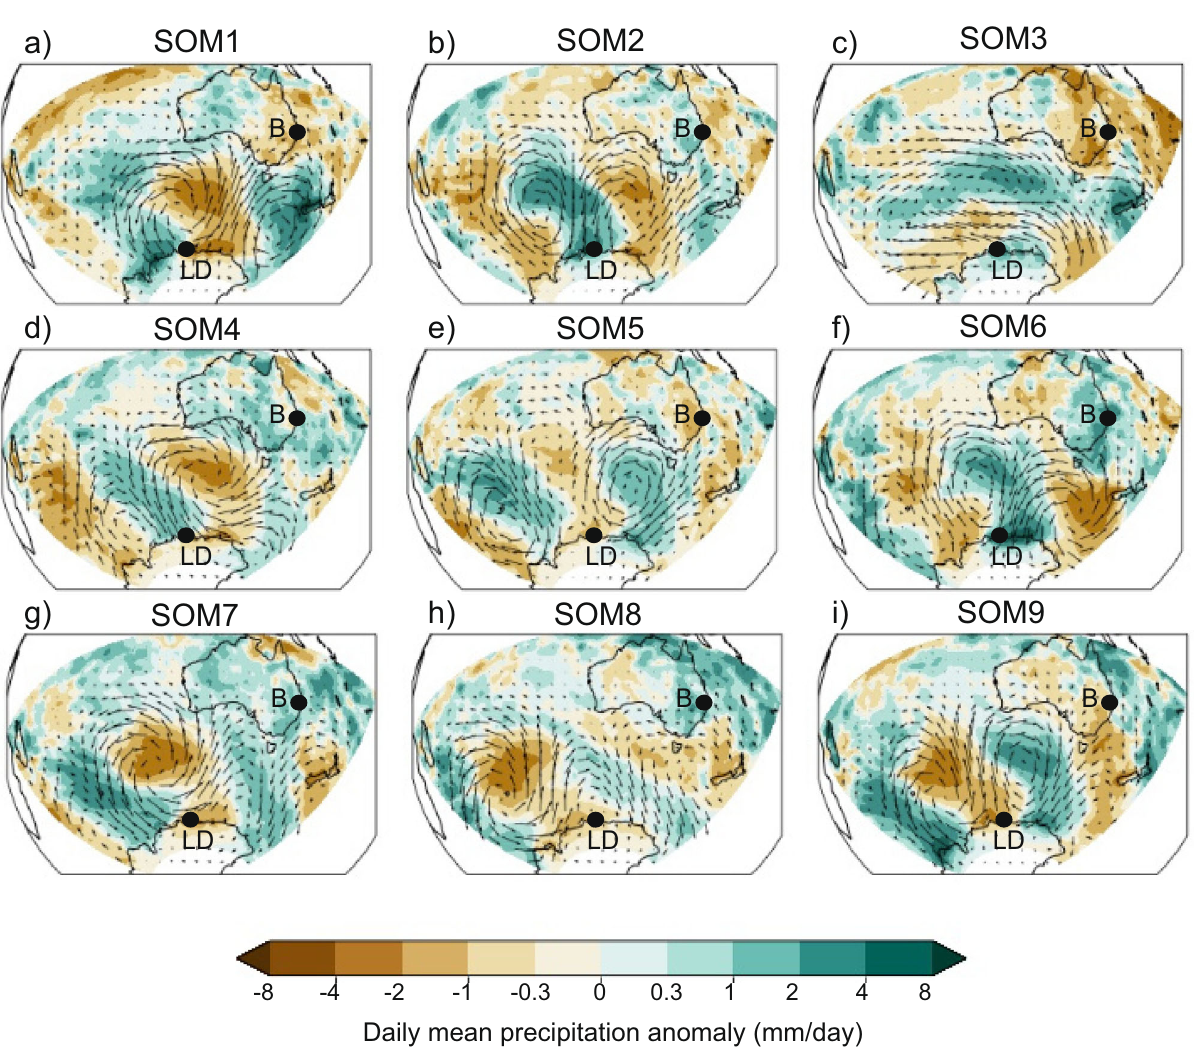
Fig. 2 NDJF daily total precipitation and surface (10 m) wind anomaly (data: ERA-Interim 58 ) for the nine SOM nodes from ref. 33 over 1979/80 to 2017/18. SOM nodes 1 to 9 are labelled ( a – i ). SOM composite anomalies calculated from the NDJF climatology (Fig. 1c). SOM3 (SOM7) supports lower (upper) LD sss composite conditions (Fig. 1d, e), re fl ecting reduced (strengthened) westerly winds near Law Dome (LD) coastline and dry (wet) eastern Australia (B = Brisbane). Note the precipitation scale is